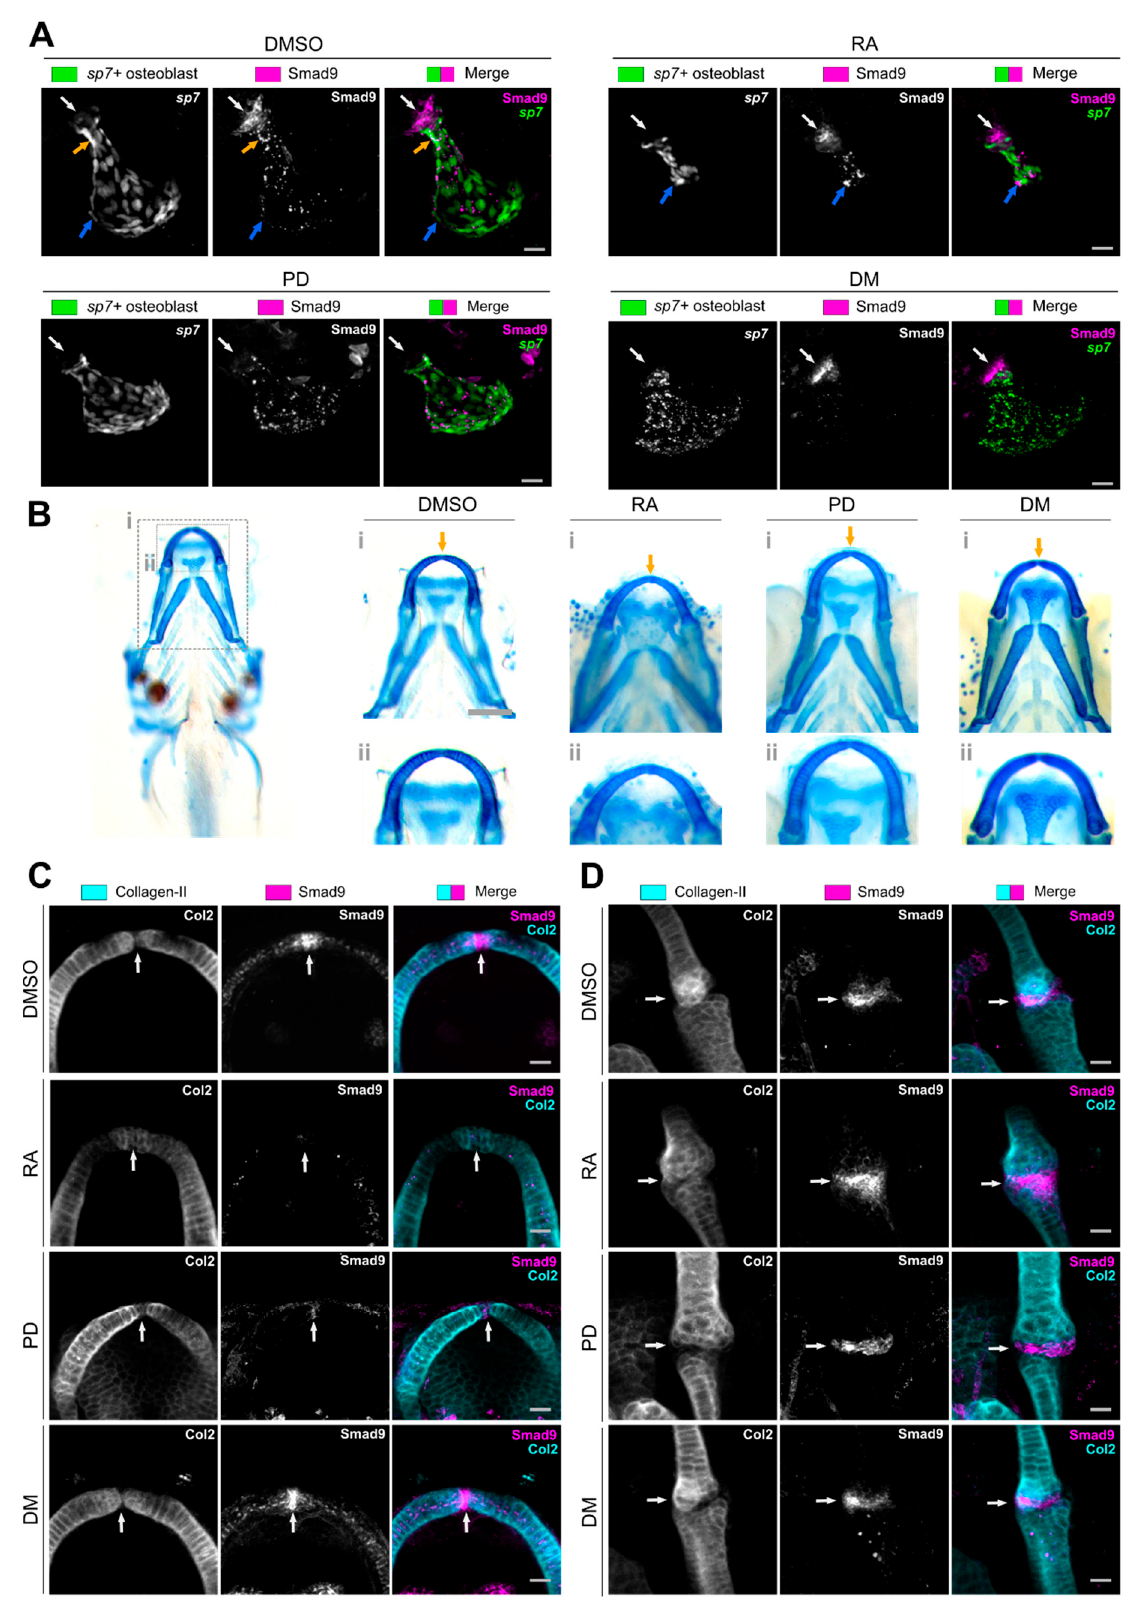
Figure 3. Pharmacological treatment alters Smad9 expression in line with changes to skeletal morphology: ( A ) Lateral view of the operculum at 5.25 dpf following 48 h treatment with either: DMSO (control), 1 µ M retinoic acid (RA), 25 µ M prednisolone (PD) or 4 µ M dorsomorphin (DM). Control larvae show Smad9 expression in the pocket of cells at the top of